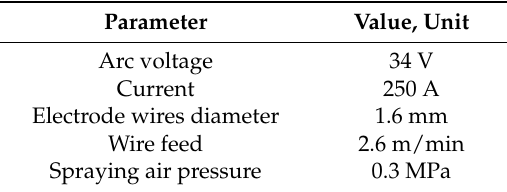
Table 1. Arc spraying